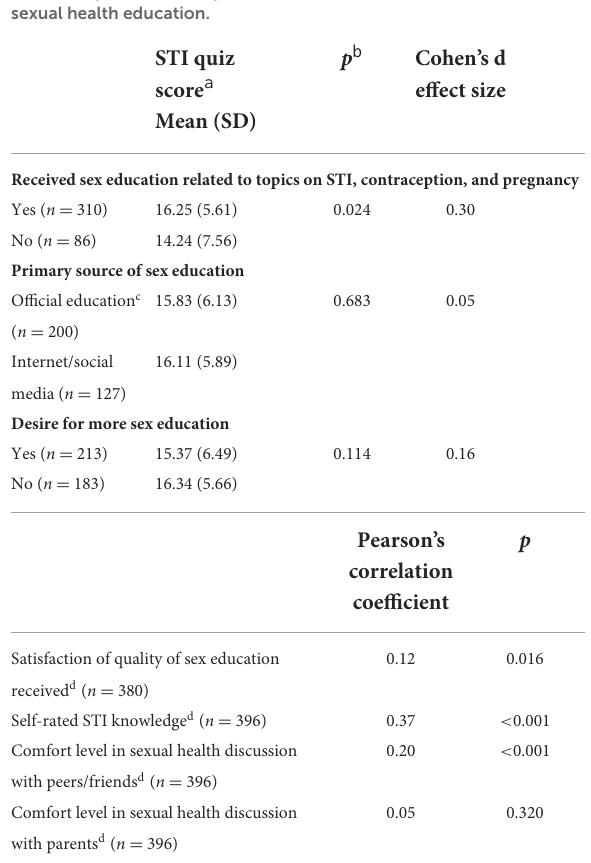
TABLE 3 Multiple linear regression to explore the socio-demographic factors associated with the sexually transmitted infection quiz score.